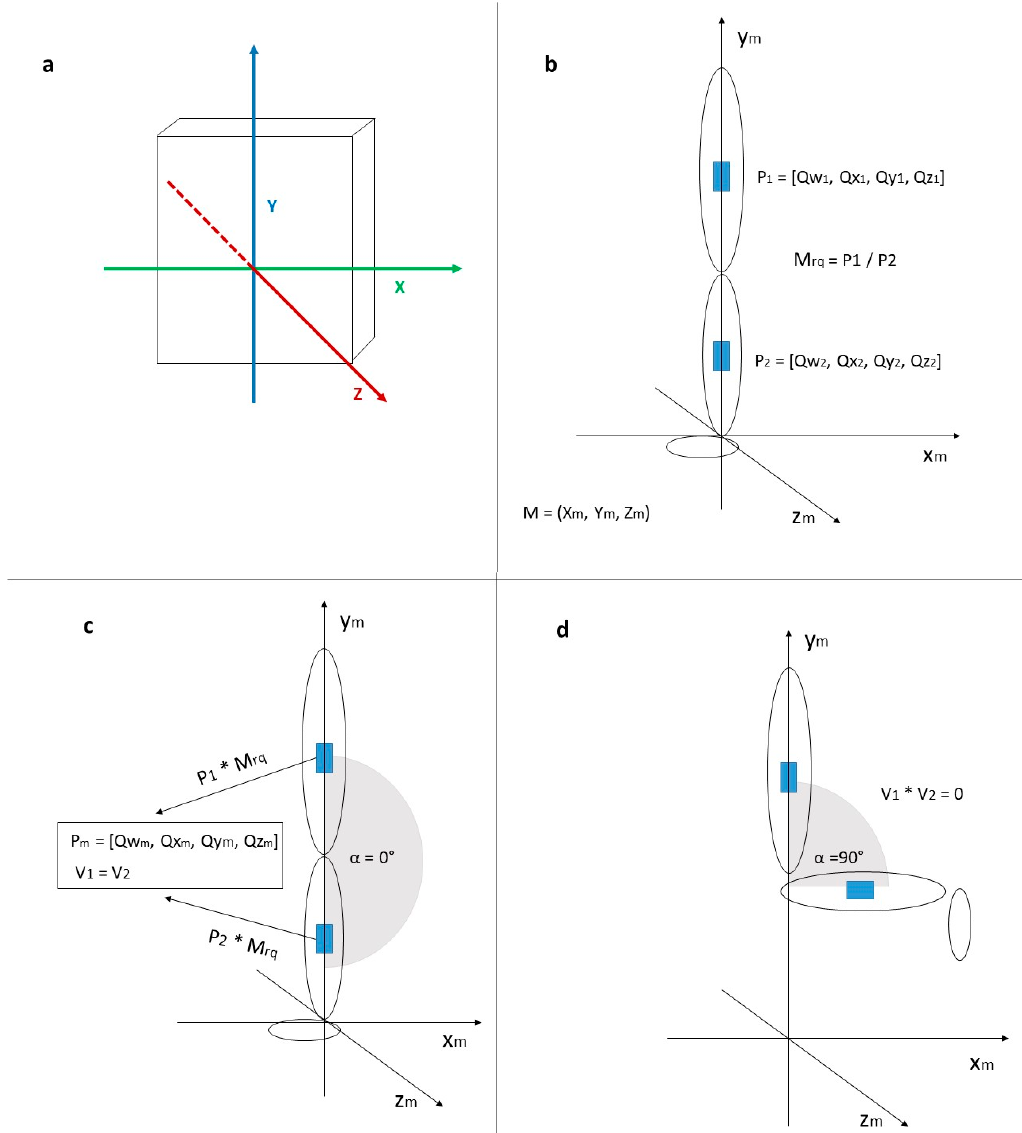
Figure 2. ( a ) Sensor orientation to reference frame according to manufacturer, ( b ) sensors positioned on the leg before initialization procedure. Each sends position data (P 1 , P 2 ) separately. ( c ) After